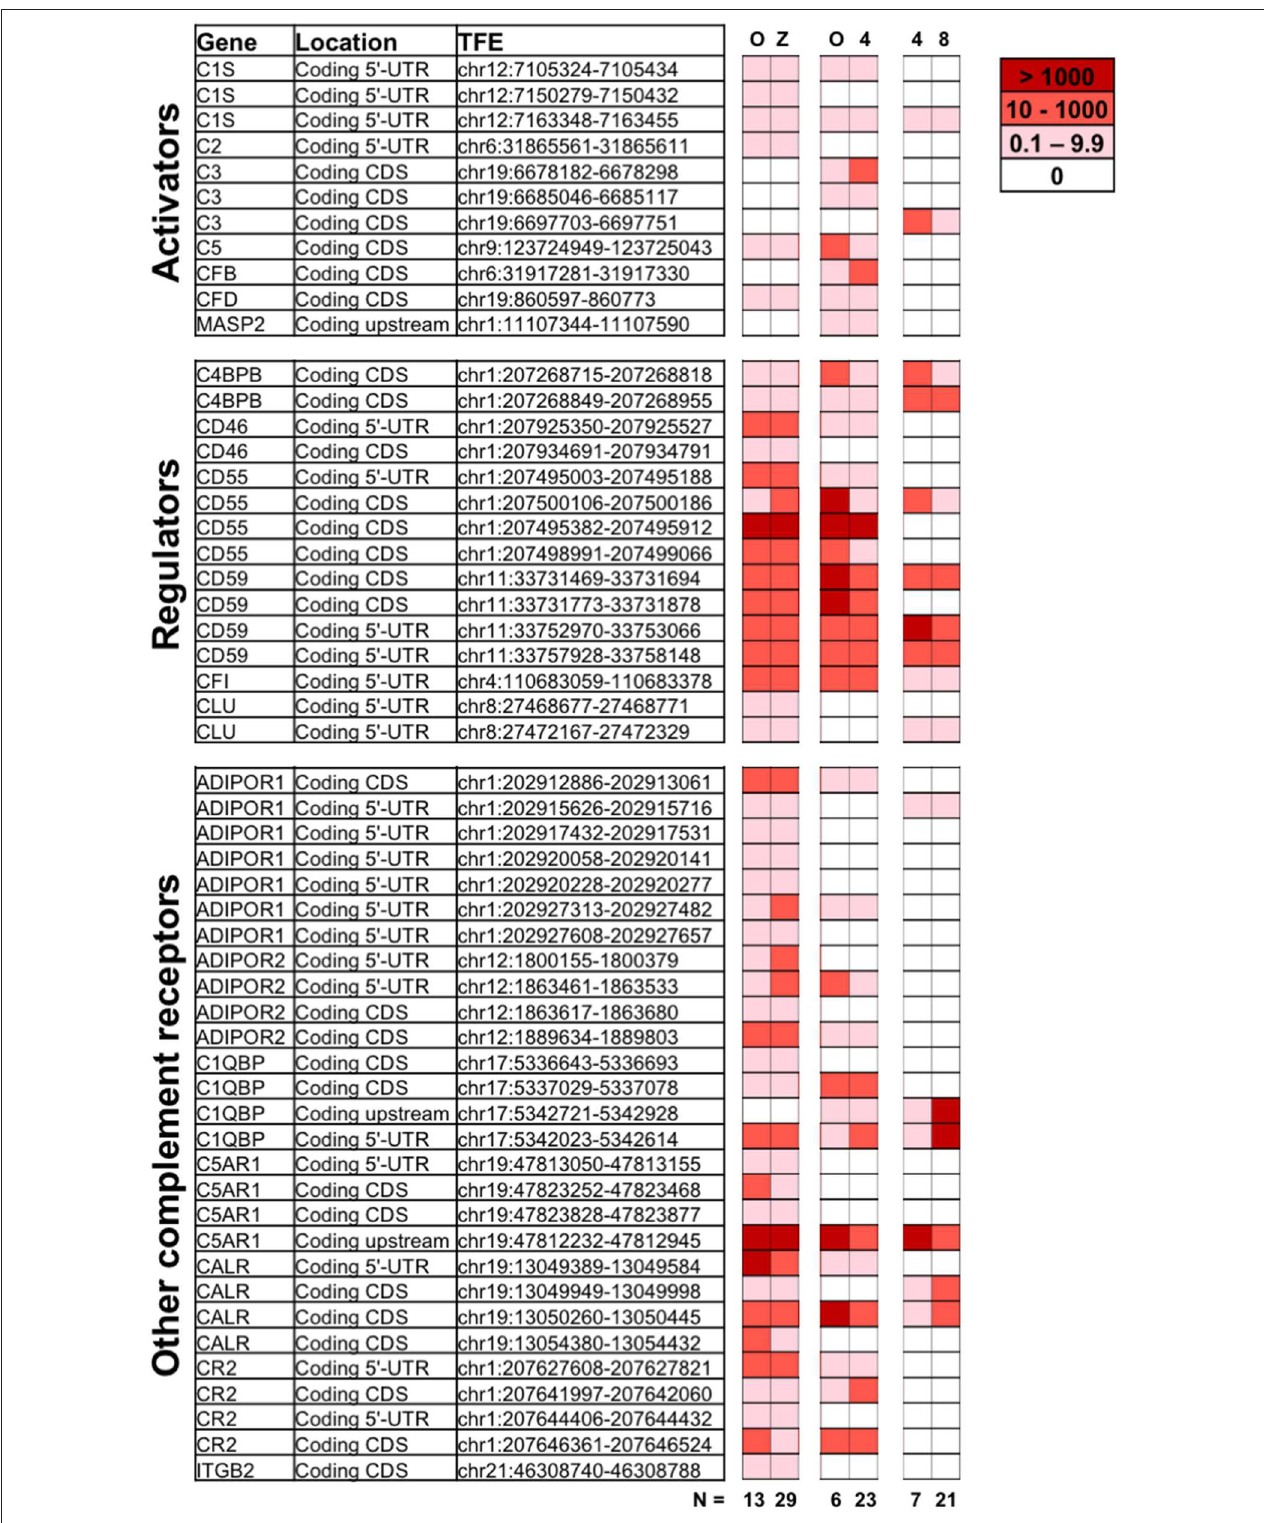
FIGURE 1 | Expression of complement genes in developing embryos. Single-cell RNA sequencing was applied on oocytes (O), zygotes (Z), 4-cell stage, and 8-cell stage embryos to identify the expression of complement related genes during early development. Included are reads tagged to the 5 ′ UTR (Coding 5 ′ -UTR) or proximal upstream region (Coding upstream), as well as known coding sequence (Coding CDs). The numerical values indicating normalized expression levels are determined